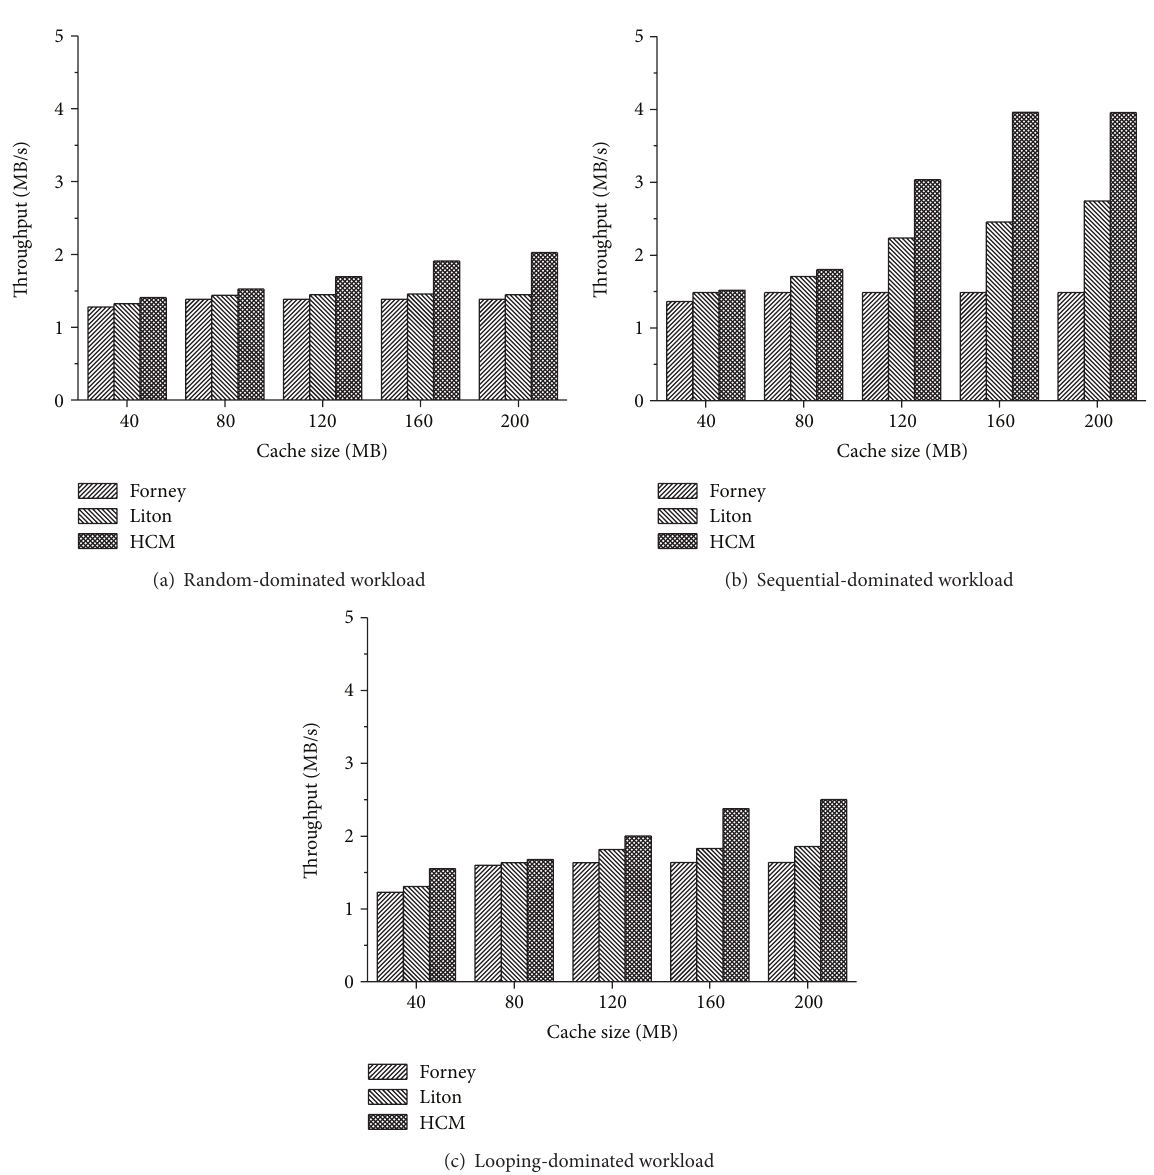
Figure 4: Throughput of the HCM and Forney algorithm with varying cache